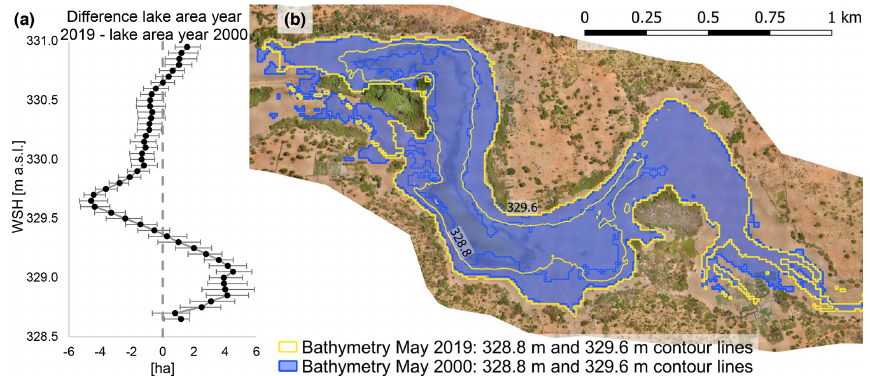
Figure 12. (a) Difference in lake area as a function of water surface height (WSH) based on the bathymetries for May 2019 and May 2000. The error bars reflect the 95% CI of the sediment erosion and deposition rates that were used to reconstruct the bathymetry of the year 2000. (b) Lake contour lines for a WSH of 328.8ma.s.l. and 329.6ma.s.l. considering the bathymetries of the years 2000 and 2019, respectively.